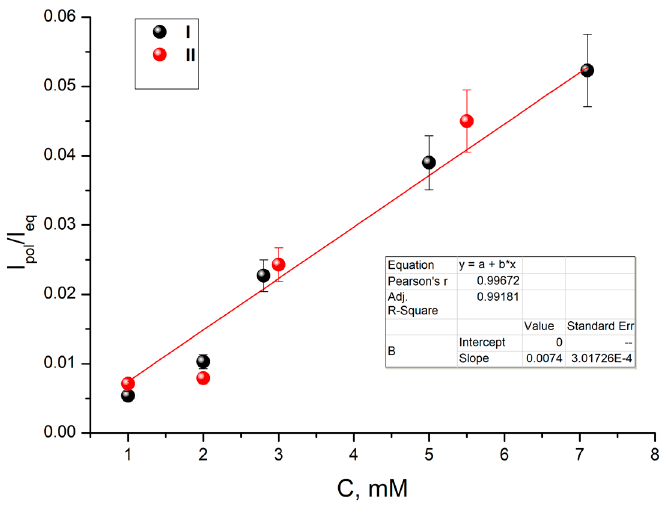
Figure 6. Concentration dependencies of the CIDNP coefficients of methyl protons of NHCOCH 3 group for I and II .